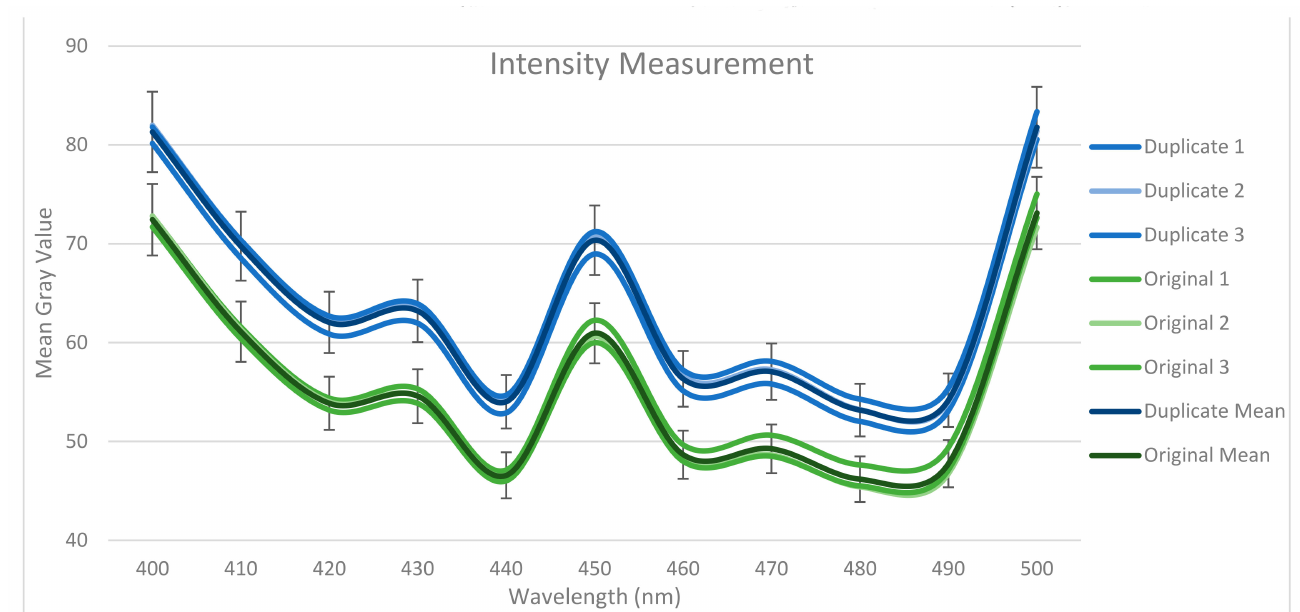
Figure 7. MGVs of the duplicate and original samples in ROI